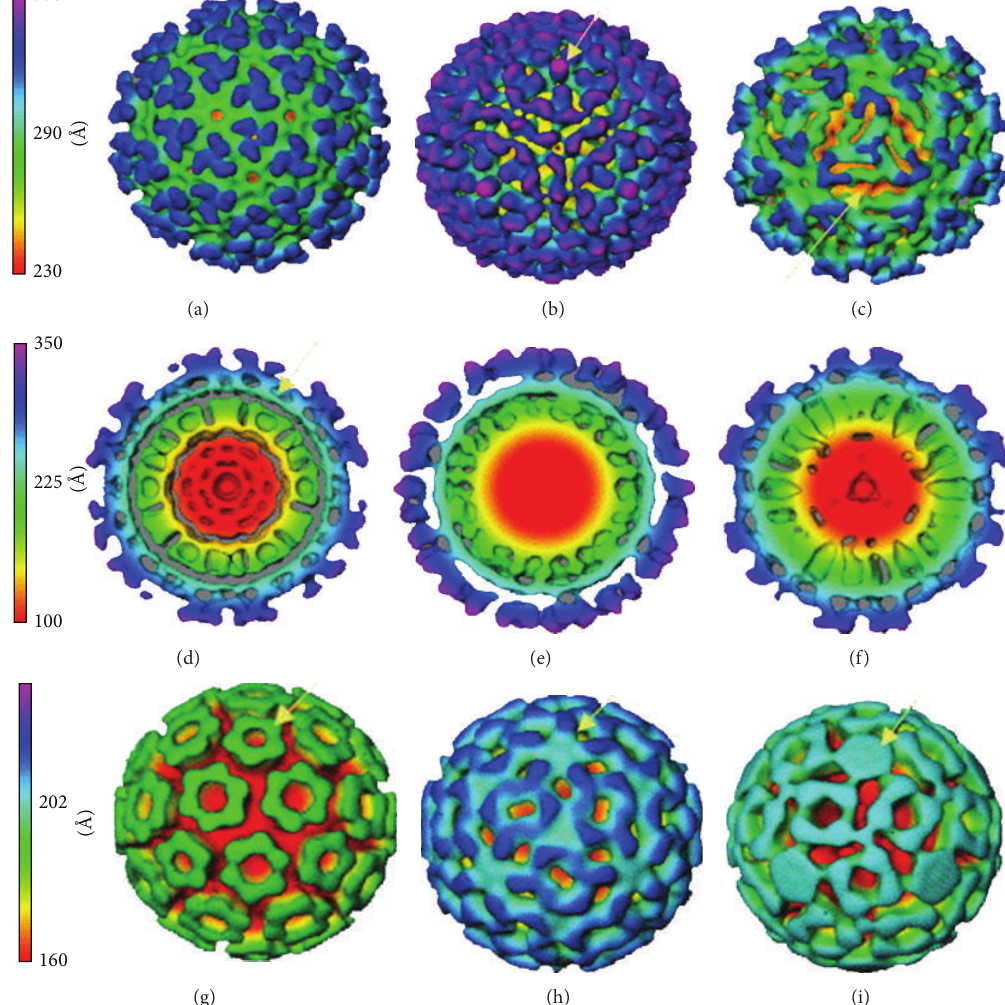
Figure 10: Conformational changes in Sindbis virus after exposure to various pH conditions. The three-dimensional structures of Sindbis virus surface at 28 ˚A resolution viewed along icosahedral threefold axes ((a)–(c)). Central cross section of Sindbis virus ((d)–(f)). Three- dimensional structure of the Sindbis virus capsid (inside the membrane bilayer) viewed along the icosahedral threefold axes ((g)–(i)). The reconstructions are colored according to a range of radii (key displayed) at different pH conditions ((a), (d), and (g)). Sindbis virus at pH 7.2. ((b), (e), and (h)) Sindbis virus at pH 5.3. ((c), (f), and (i)) Sindbis virus exposed to pH 5.3 (5min) and returned to pH 7.2. Arrows: (b) protrusion at the fivefold axis; (c) fissure at twofold axis; ((d), (e), and (f)) fivefold axis; (g) region of cross-section occupied by the membrane bilayer. Paredes et al. 2004